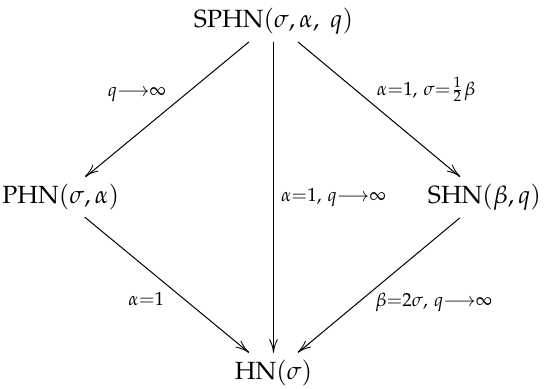
Figure 3. Relationships among distributions in the SPHN